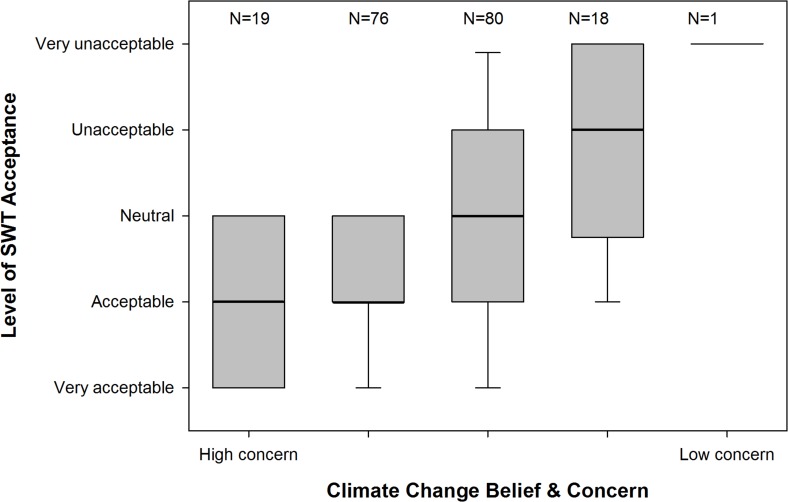
The difference in SWT acceptance between respondents with different levels of climate change belief and concern.The thick line shows the median while the outer edge of boxes shows 25th & 75th percentile. Confidence intervals represent 10th & 90th percentile.